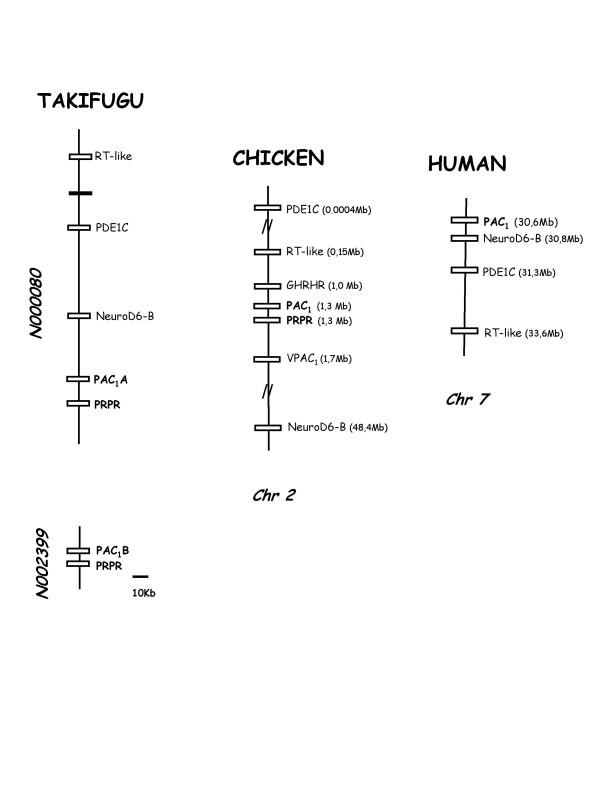
Short-range linkage analysis of the PAC1 receptors. The gene environment of Takifugu, chicken and human PAC1 regions is represented. Homologue genes present in all three study organisms are represented by open boxes and black boxes represent flanking genes that had no corresponding homologues. Genes are named according to the HUGO annotation and PAC1 genes are in bold. Takifugu scaffolds (assembly 4) are represented using the NIX annotation [40]. The gene environment of PAC1 in Xenopus is not represented since it was very incomplete. The Takifugu gene environment is represented and the scale corresponds approximately to 10 Kb and the relative position of linked genes in the chromosomes of the chicken and human is given.